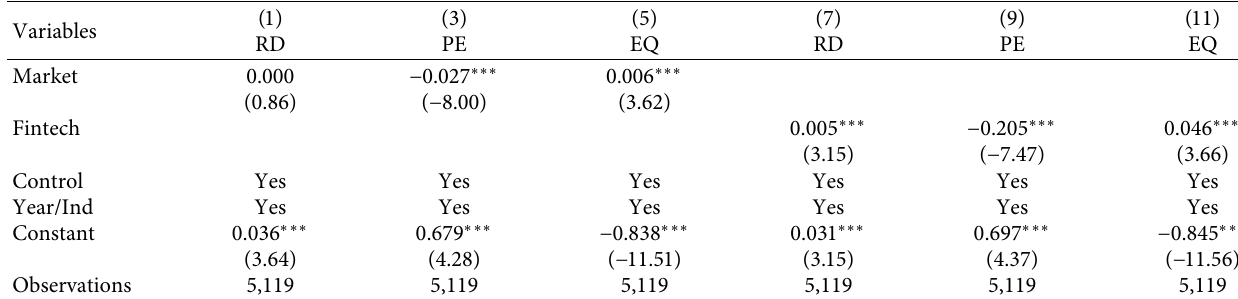
Table 10: Regression results for large-scale